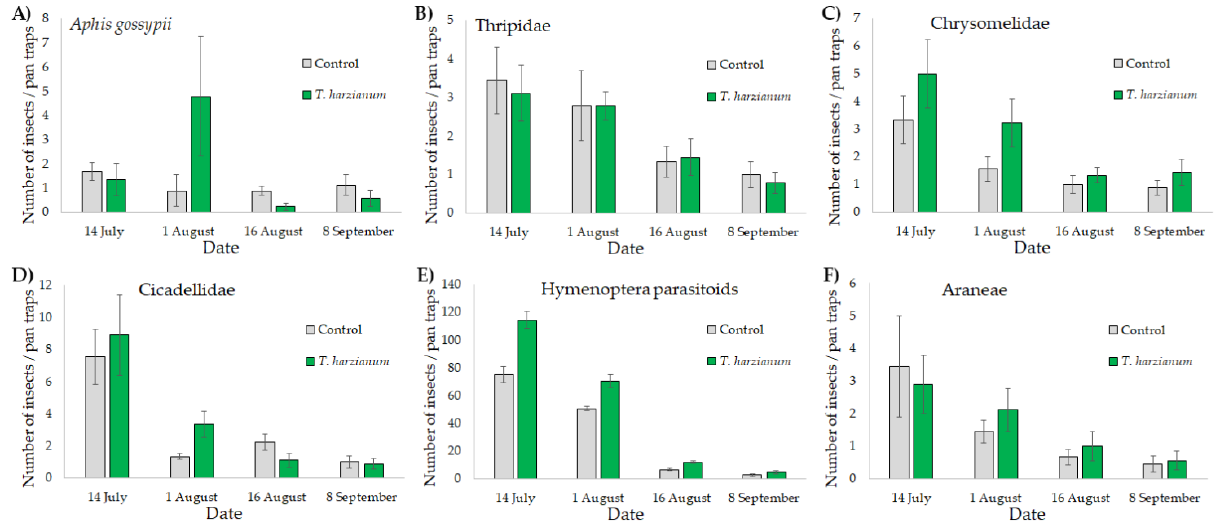
Figure 4. Mean values (± standard errors) of the number of winged Aphis gossypii ( A ), Thripidae ( B ), Chrysomelidae ( C ), Cicadellidae ( D ), Hymenoptera parasitoids ( E ), and Araneae ( F ) collected with pan trap sets placed near plants inoculated with T. harzianum T22 and control at the four sampling dates.